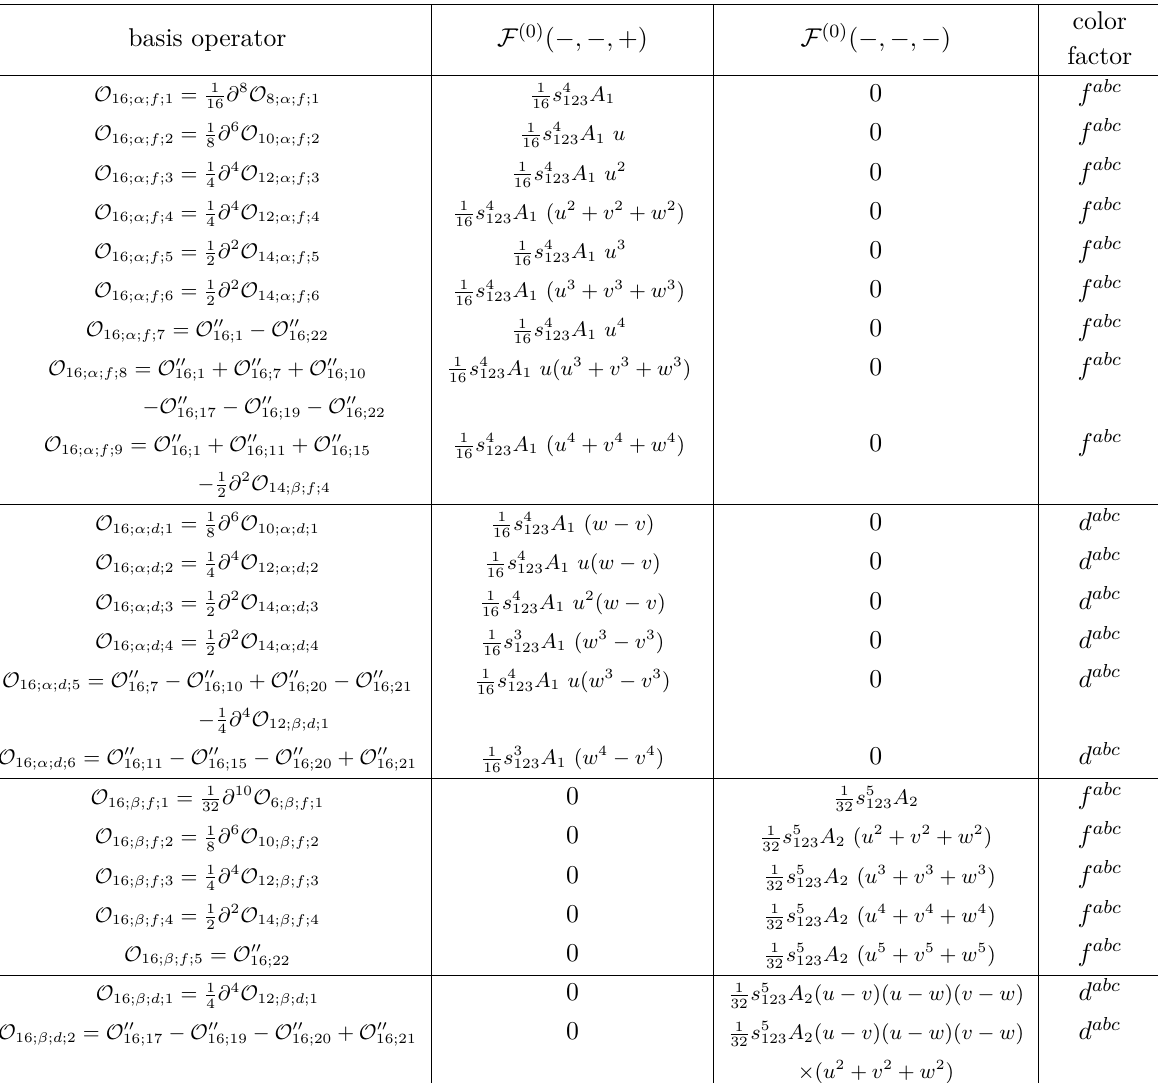
Table 16 . Final basis operators at dimension